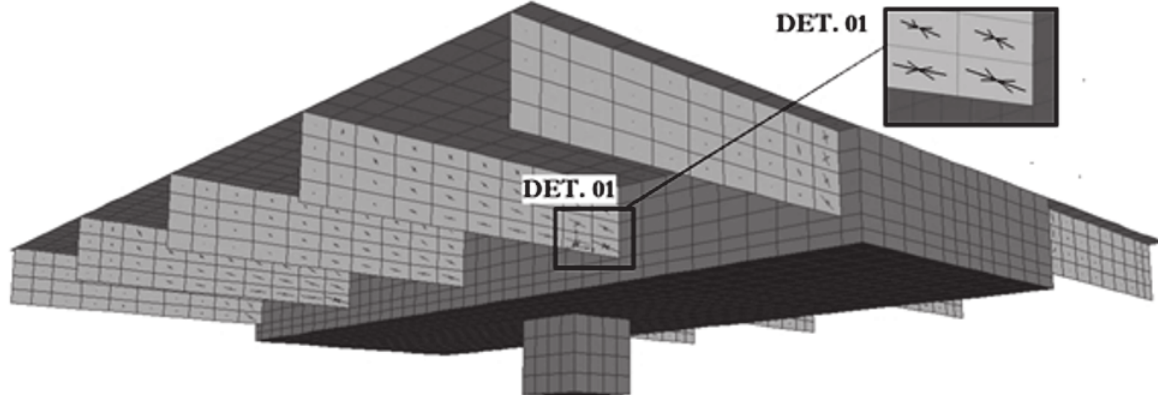
Fluxo de cargas na ligação